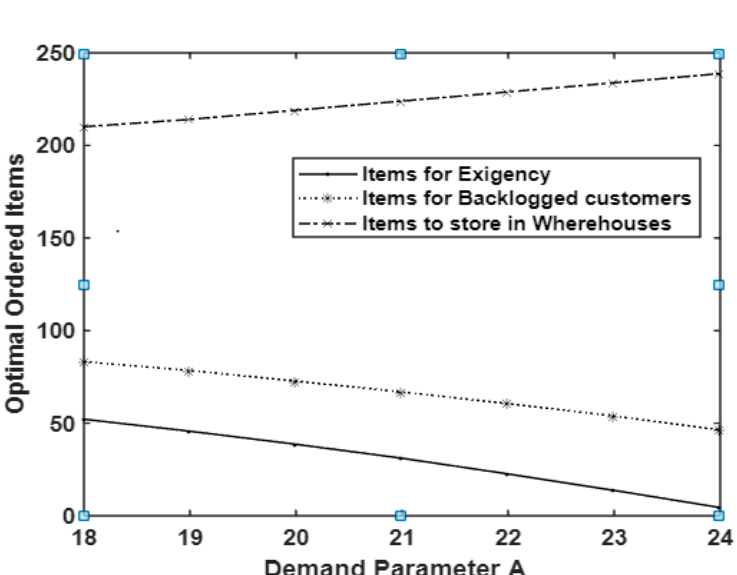
Figure 5. The effect of changes in demand parameter 𝒷 on optimal ordering items. 4.2.2. Effect of Changes in Interest Rate ℐ 𝒫 and Discount Rate 𝜉 on Arriving at Optimal Total Cost and Optimal Ordering Quantity The variations in the interest rate and discount rates on compulsory complete pre- payment option, influence on optimum total cost and optimum items ordered from both regular and local supplier with the following same environment for 𝒜 = 22 ; 𝒷 = 0.24 ; 𝑡 (cid:2869) = 3 ; 𝑡 (cid:2870) = 5; 𝜂 (cid:3045) = 0.07 ; 𝜂 (cid:3042) = 0.11 ; 𝒪 (cid:2869) = 900 ; 𝒪 (cid:2870) = 200 ; 𝒫 (cid:2869) = 82 ; 𝒫 (cid:2870) = 90 ; ℋ (cid:3045) = 10 ; ℋ (cid:3042) = 4 ; 𝒟 (cid:3045) = 9 ; 𝒟 (cid:3042) = 5.7 ; 𝒞 (cid:3046) = 8.7 ; ℳ = 2 are observed. An increase in interest rate ℐ 𝒫 are positively correlated with the optimum total cost and negatively correlated with length of stock out period. An increase in discount rate 𝜉 is negatively correlated with optimum total cost and positively correlated with length of stock out period. It is dis- played in Table 3 and depicted in Figure 6. In particular, the order for exigency is in- creased while ℐ 𝒫 increases but it is decreased while 𝜉 increases and this is clear from Figure 7. Table 3. The effect of changes in the interest rate ℐ 𝒫 and the discount rate 𝜉 on arriving at optimal total cost and optimal ordering quantity. 𝓘 𝓟